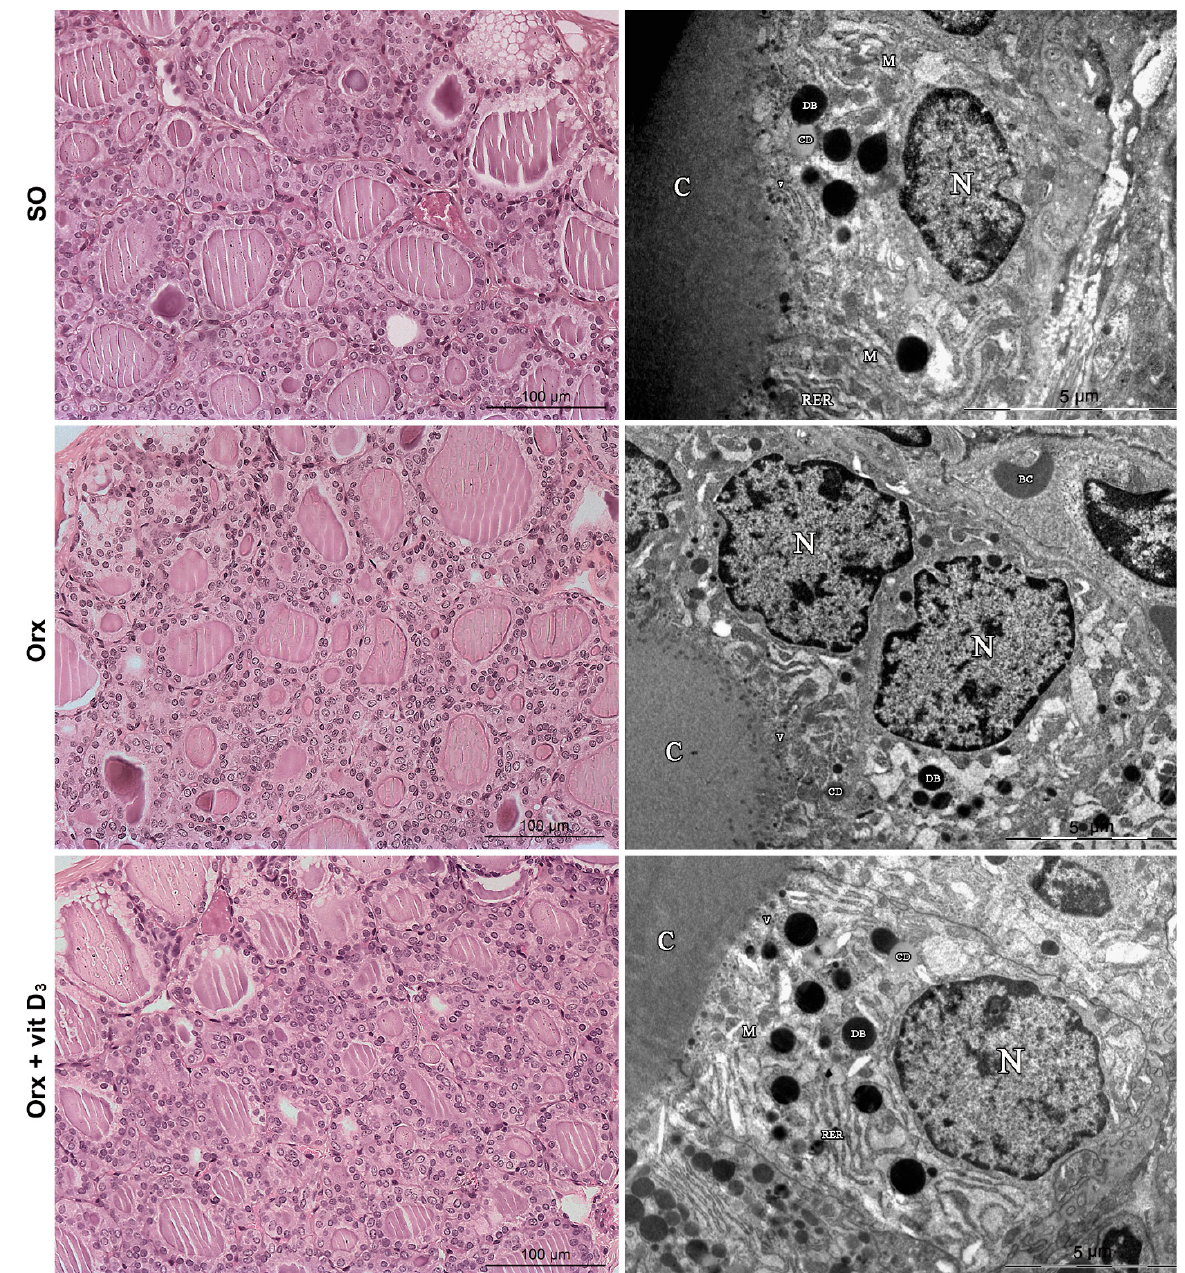
Figure 2. Representative micrographs of hematoxylin and eosin-stained thyroid sections (left col- umn) and transmission electron microscopy of thyrocytes (right column) from sham-operated (SO), orchidectomized (Orx) and orchidectomized cholecalciferol- treated (Orx + Vit. D 3 ) rats. N, nucleus; C, colloid; M, mitochondria; RER, rough endoplasmic reticulum; DB, dense bodies, lysosomes; CD, colloid droplets; V, small electron dense